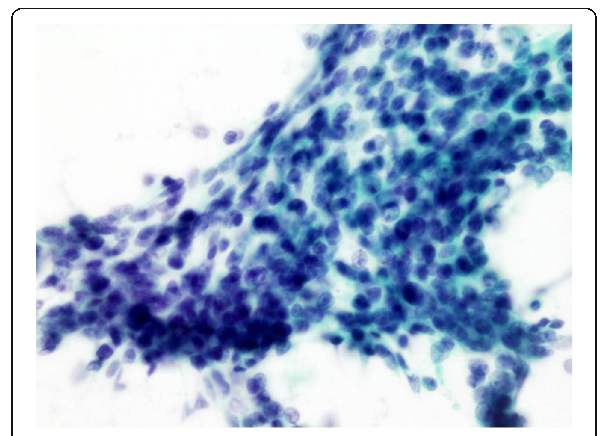
Fig. 3 Gross findings of the resected tumor. The cut surface showed a well-defined lobulated tumor containing yellowish, muddy